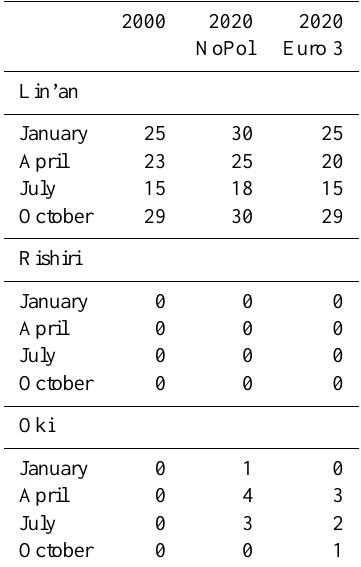
Table 9a. Days exceeding the WHO interim target-1 standard for O 3 (81ppbv).